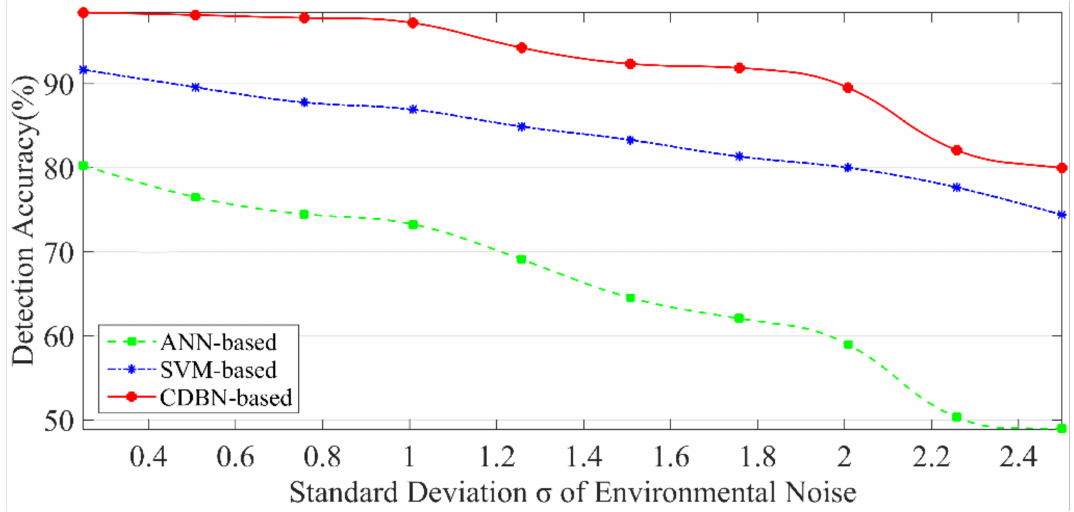
Figure 11. Accuracy of different standard deviation σ